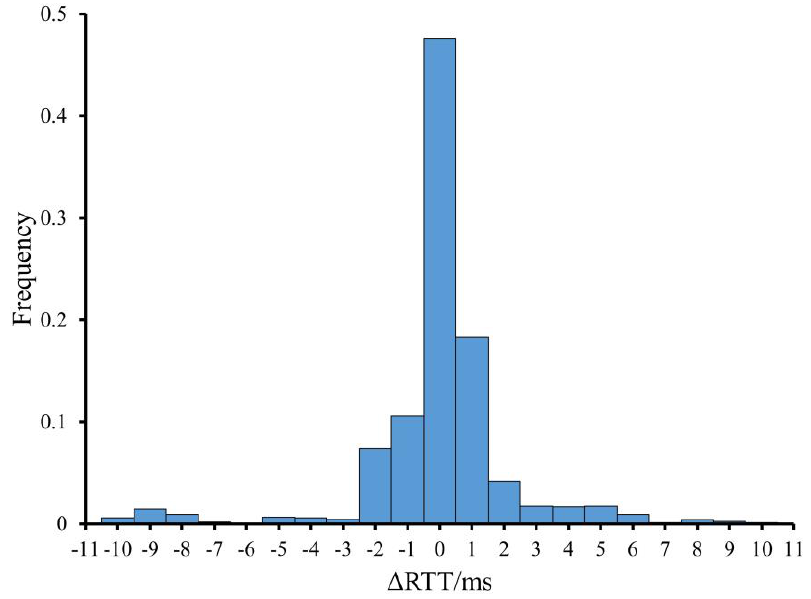
Figure 3. ∆ RTT distribution Figure 3. ΔRTT distribution histogram.